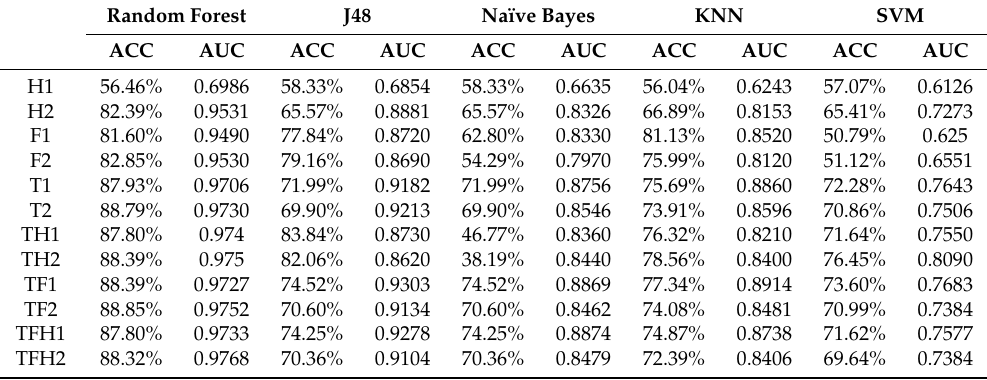
Table 10. The performance of ADM using different feature sets with the window size of 5 s at 50% overlapping.